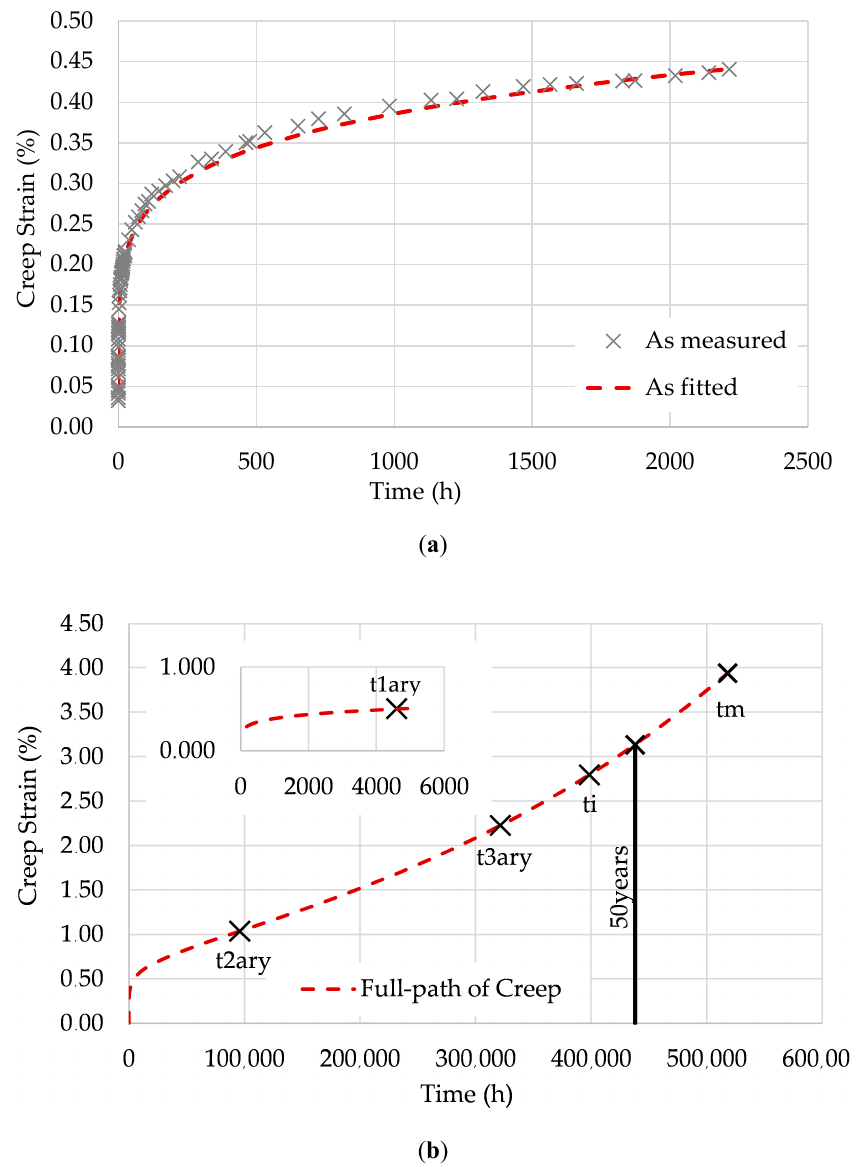
Figure 2. T28-S15: ( a ) data fitting; ( b ) full path of creep and transition points.